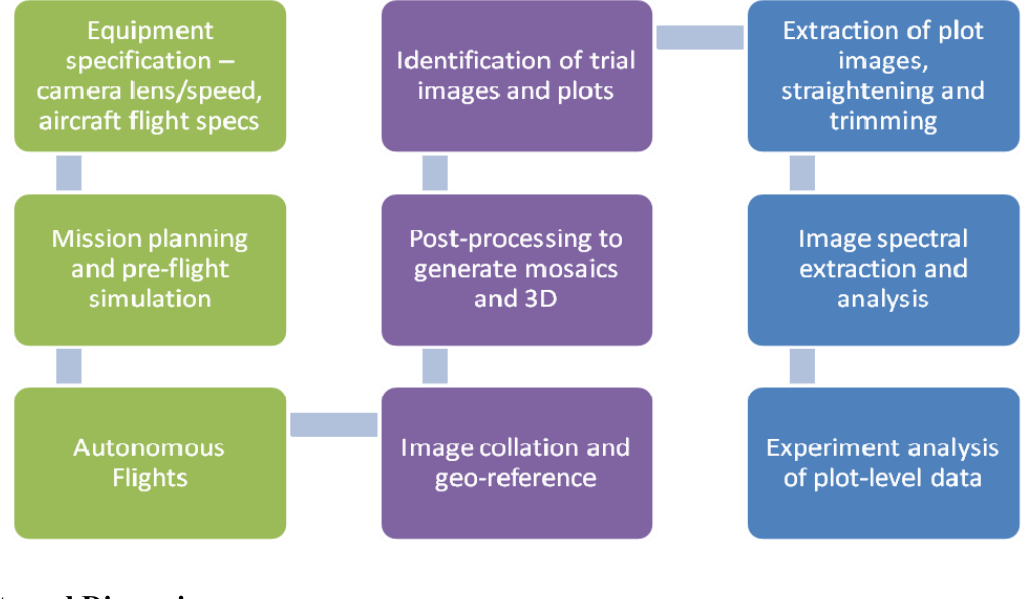
Figure 2. Aerial image analysis workflow showing pre-flight ( left ), post-flight ( centre ) and image processing ( right )